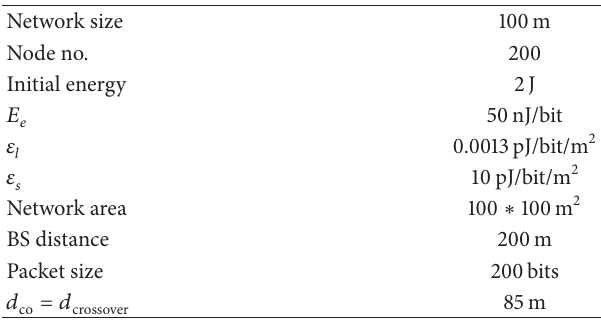
Table 5: Simulation parameters.